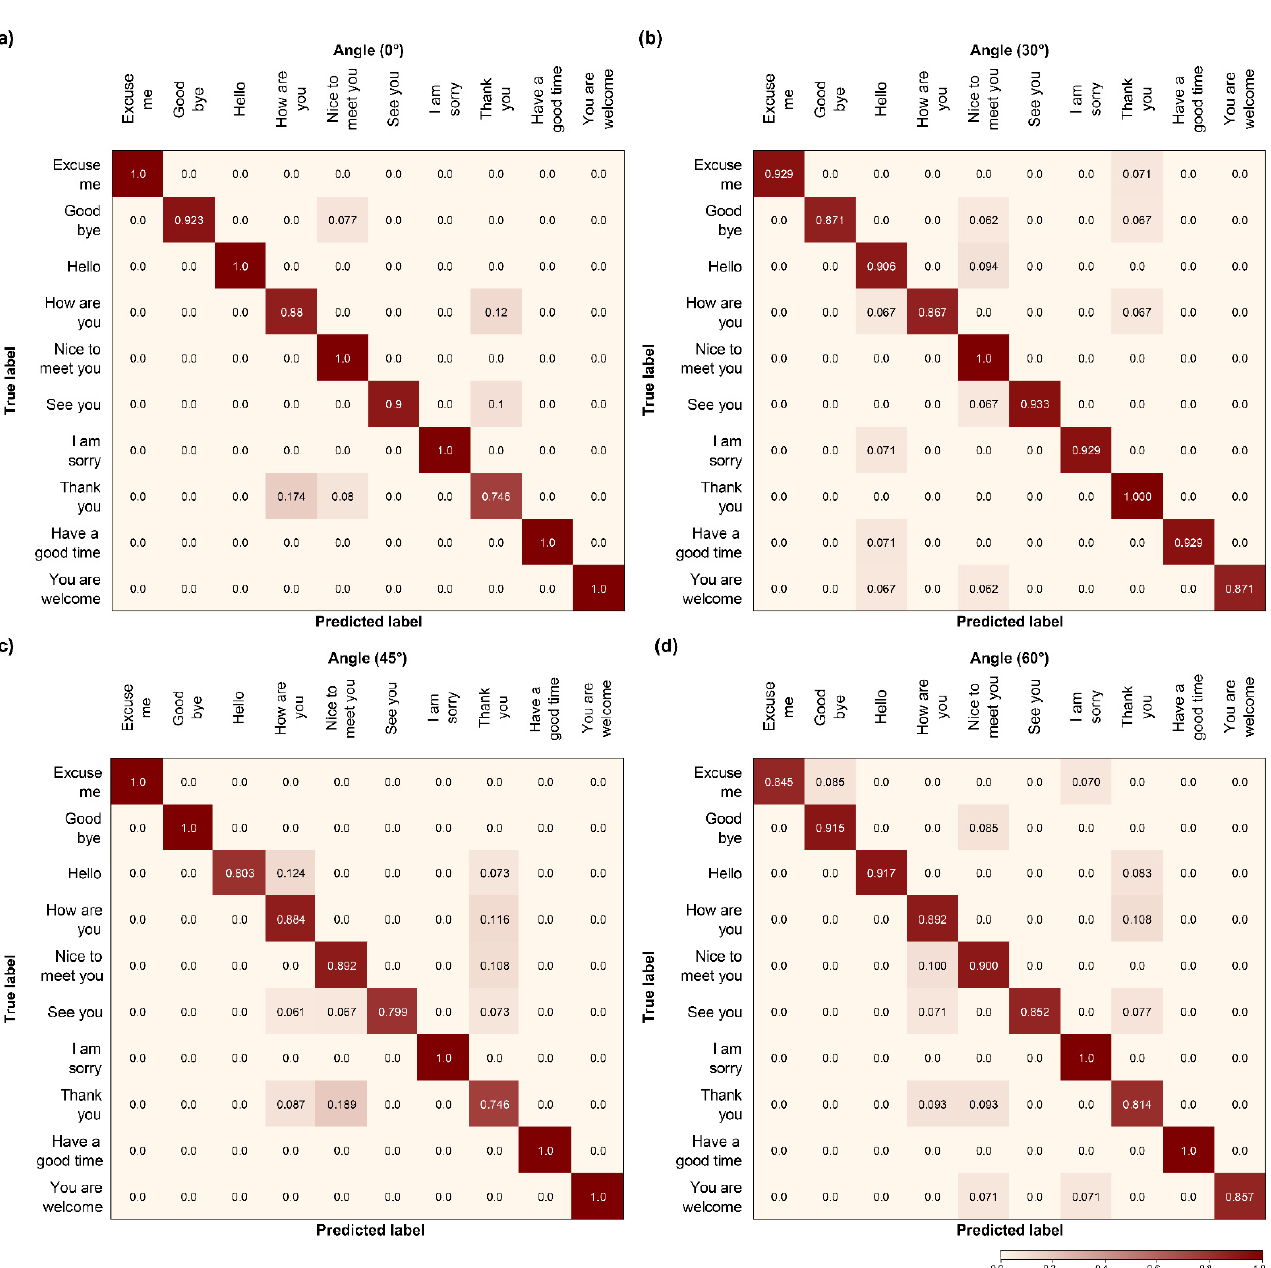
Figure 12. Comparison of confusion matrix models: ( a – d ) Model C.